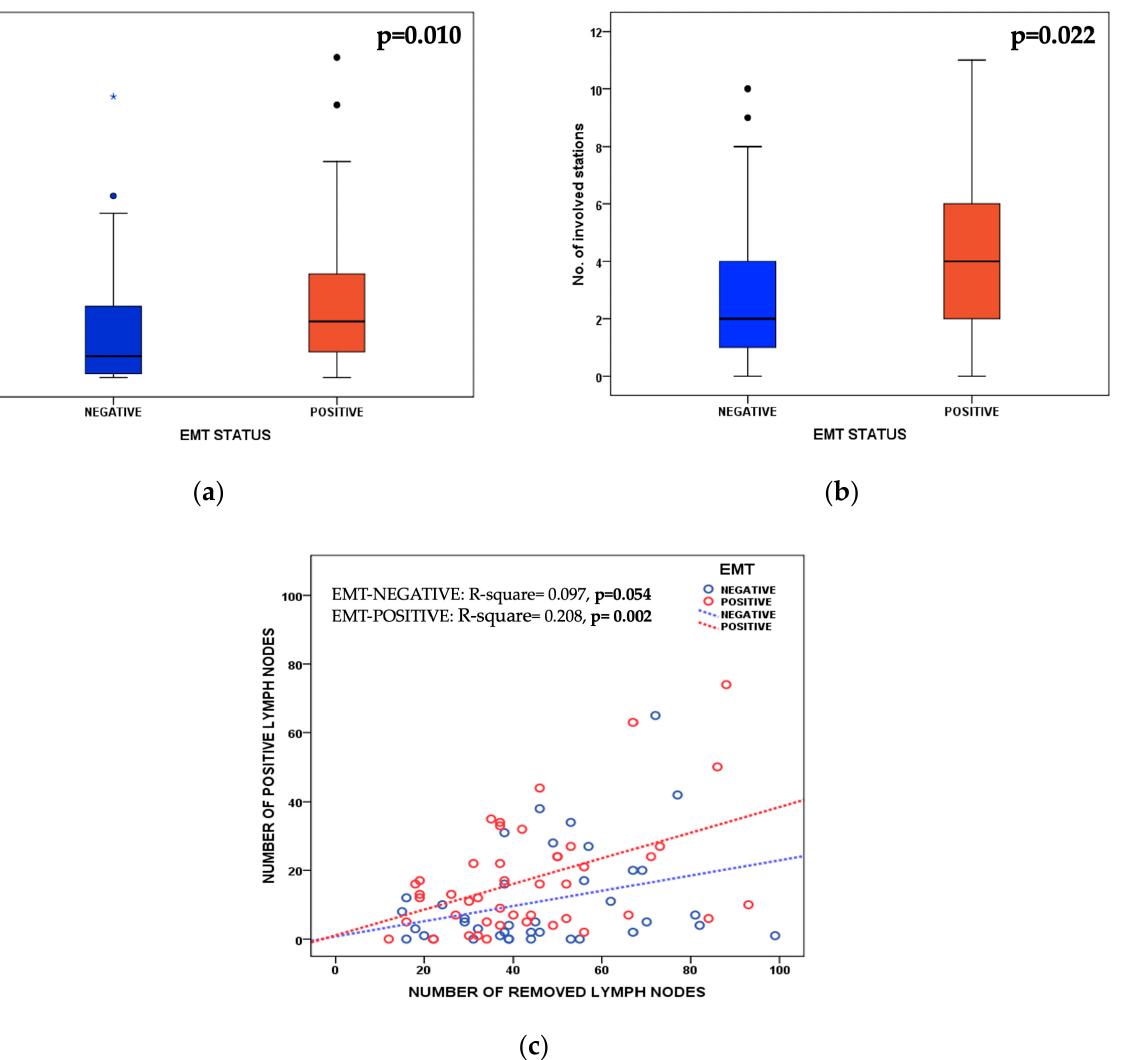
Figure 3. ( a ) Box-plot representation of the correlation between EMT status and the number of positive lymph nodes (Mann–Whitney U-test). The box represents the interquartile range (IQR), which contains 50% of the values; the lines extending from the box indicate the highest and lowest non-outlier values, while the line across the box indicates the median value. Circles represent “mild” outliers, i.e., values between 1.5 and 3.0 times the IQR; asterisks represent “extreme” outliers, i.e., values more than 3.0 times the IQR. ( b ) Box-plot representation of the correlation between EMT status and the number of metastatic lymph nodal stations classified according to the JGCA guidelines (Mann–Whitney U-test). A median number of 10 lymph node stations for patients were removed (range 6 to 15); a total number of 924 lymph node stations were analyzed. ( c ) Linear correlation between the number of removed and positive lymph nodes in EMT-positive and EMT-negative cases. Table 1. Association between EMT status and clinical–pathological variables in MSS diffuse-type gastric cancer.